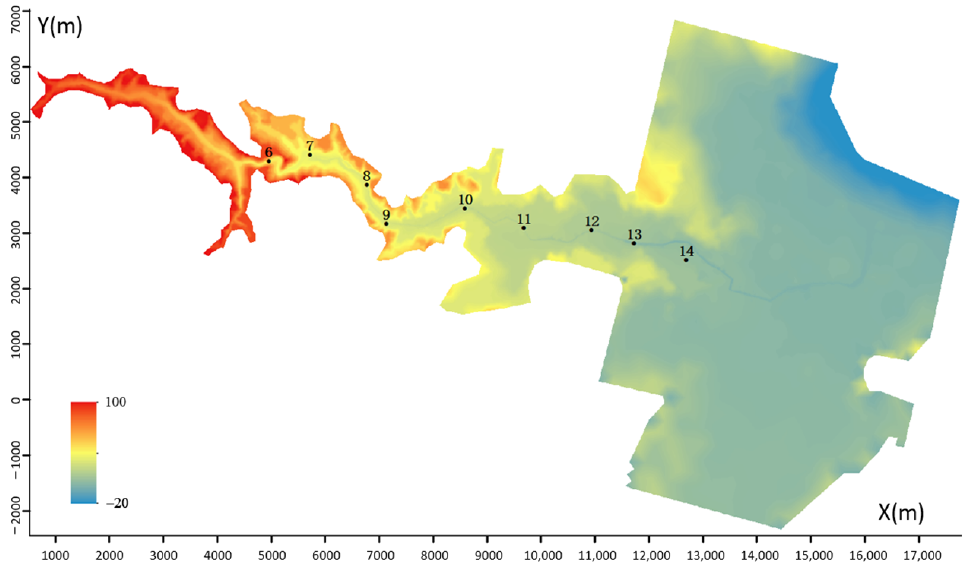
Figure 1. DEM and locations of the gauges.